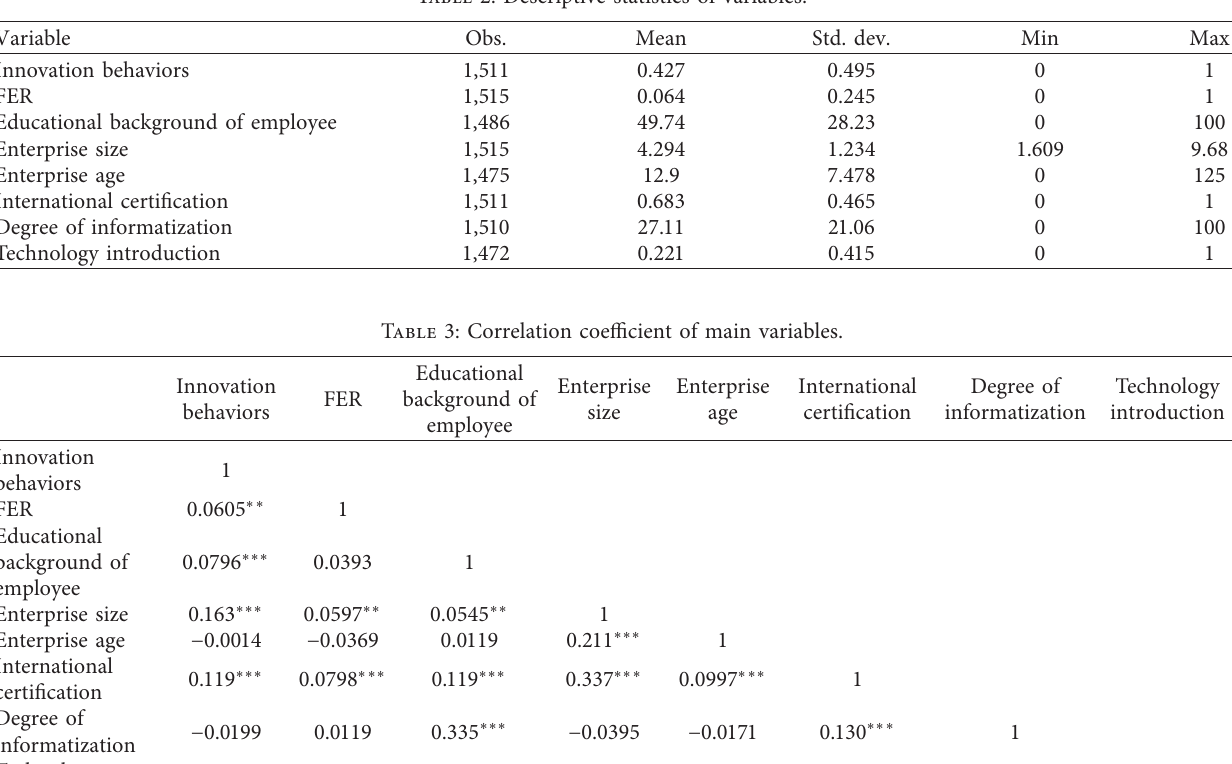
Table 2: Descriptive statistics of variables.